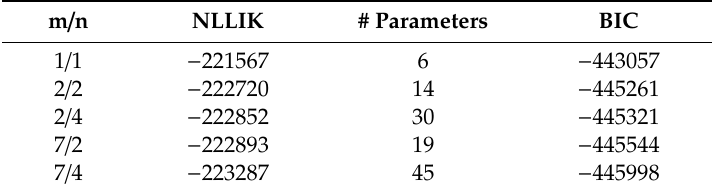
Table A4. Negative log-likelihood, number of parameters and BIC for the various choices of m and n. m /